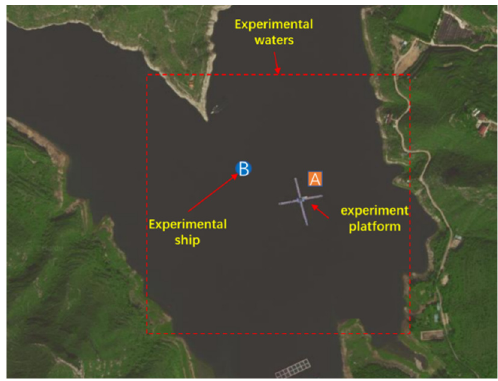
Figure 13. Outdoor experimental water area map.